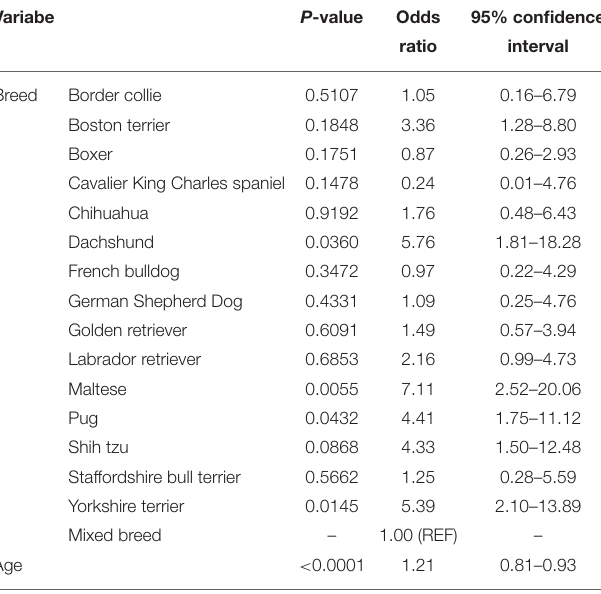
TABLE 4 | Breed-specific age-adjusted odds ratios and associated 95% confidence intervals for diagnosis of asymmetric encephalopathy/encephalomyelopathy in dogs undergoing brain imaging.